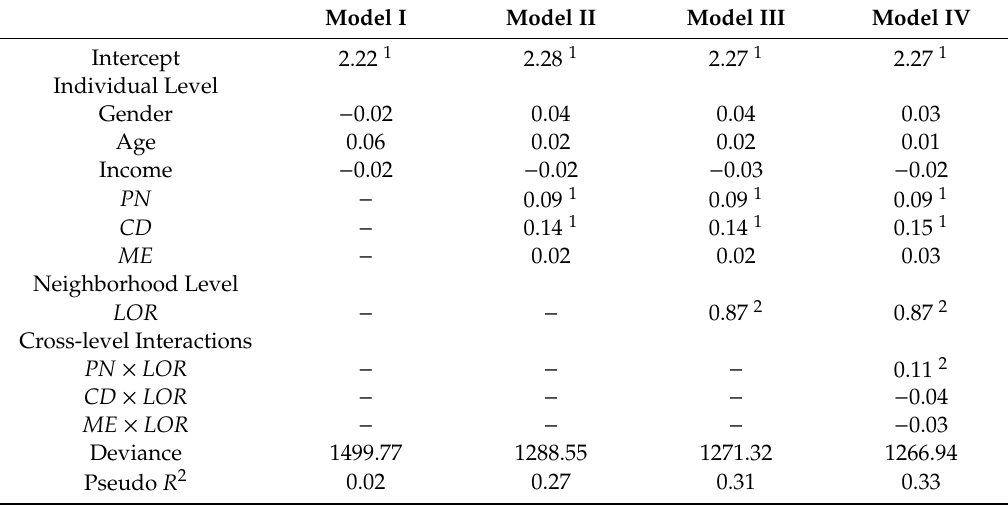
Table 5. Results of HLM